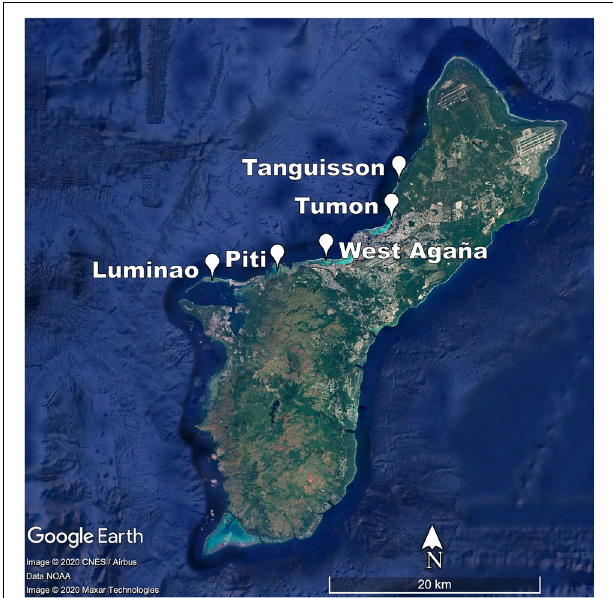
FIGURE 1 | Map of survey